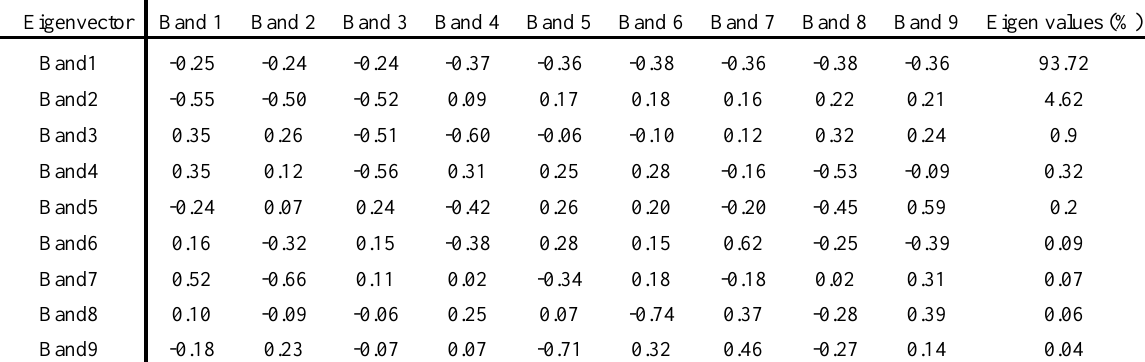
Table 1. PCA eigenvector matrix of 9 bands of ASTER data in VNIR and SWIR rang for Ardestan scene